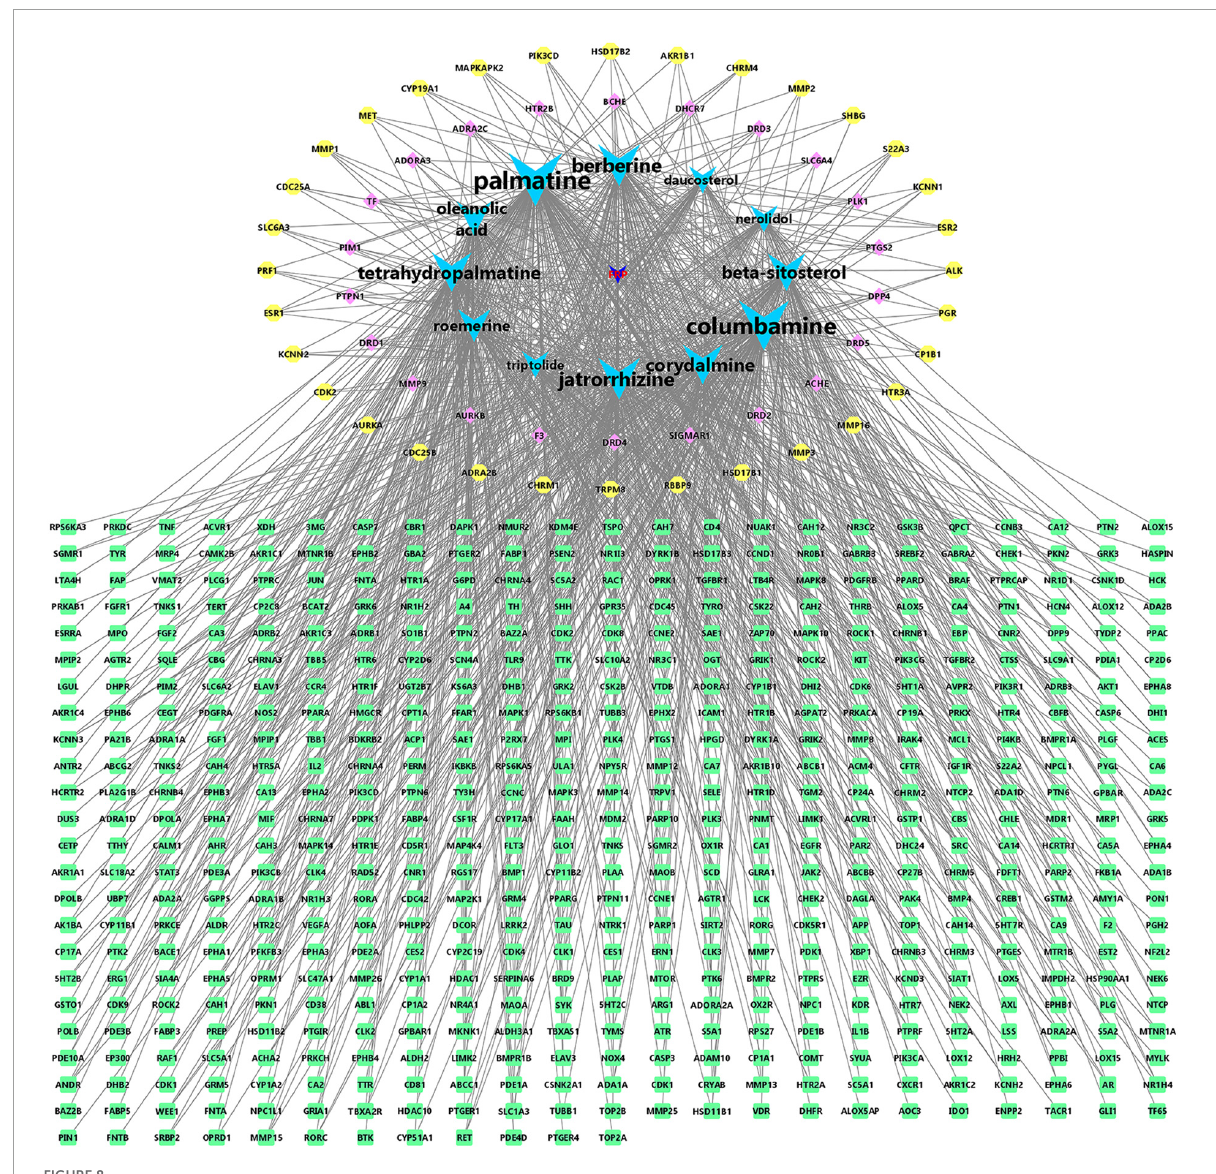
FIGURE8 Fibraurea recisa Pierre (FRP)-active ingredient-target visualization. Green is the gene with a degree of 3, yellow is the gene with a degree of 4, pink is the gene with a degree of 5–8, blue is the main ingredients with a degree of 46–156, and dark blue is the traditional Chinese medicine